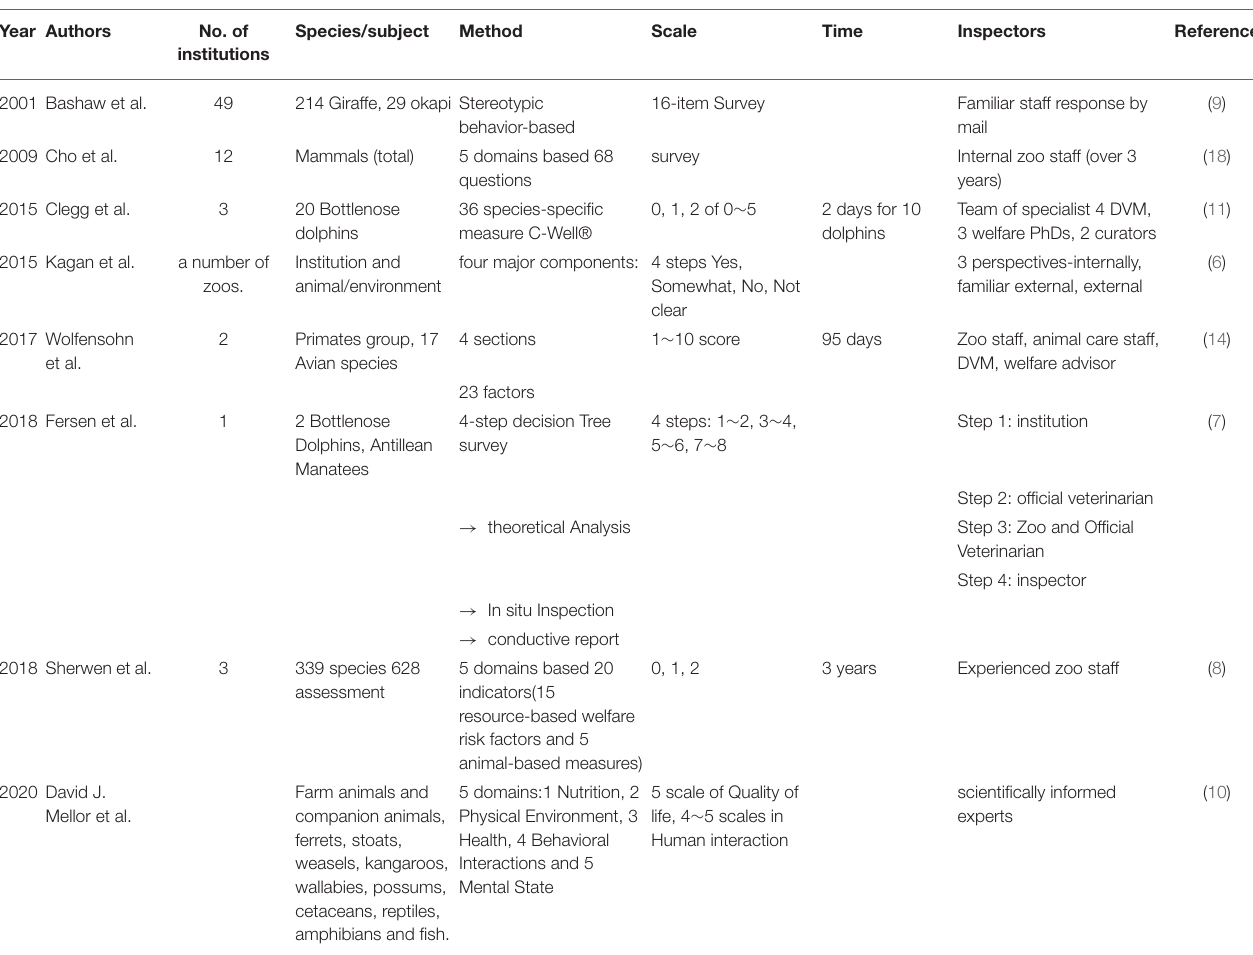
TABLE 1 | Literatures on animal welfare